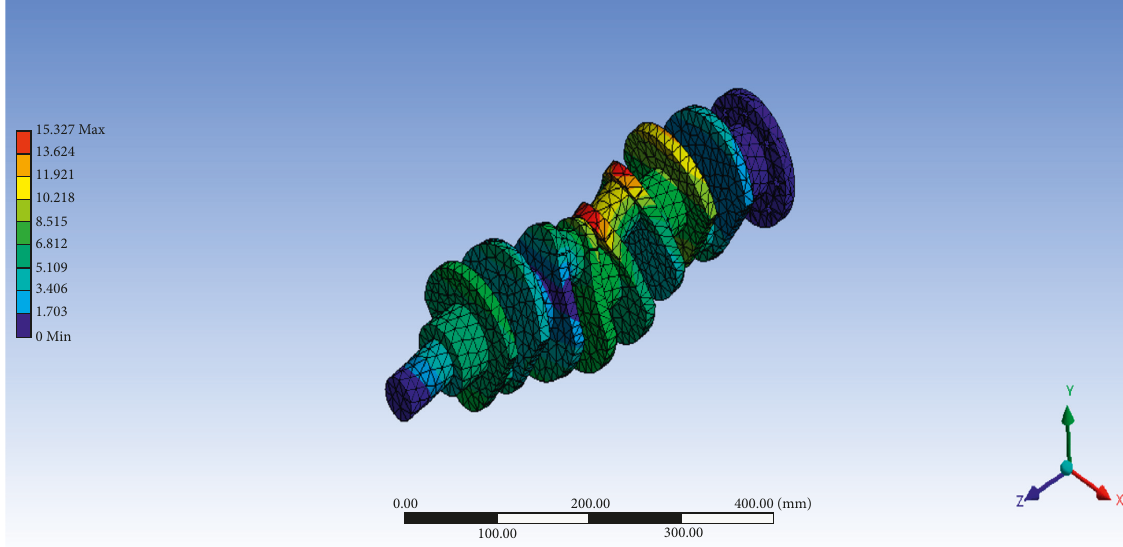
Figure 8: Deformation of stainless-steel crankshaft at the fourth mode of vibration.